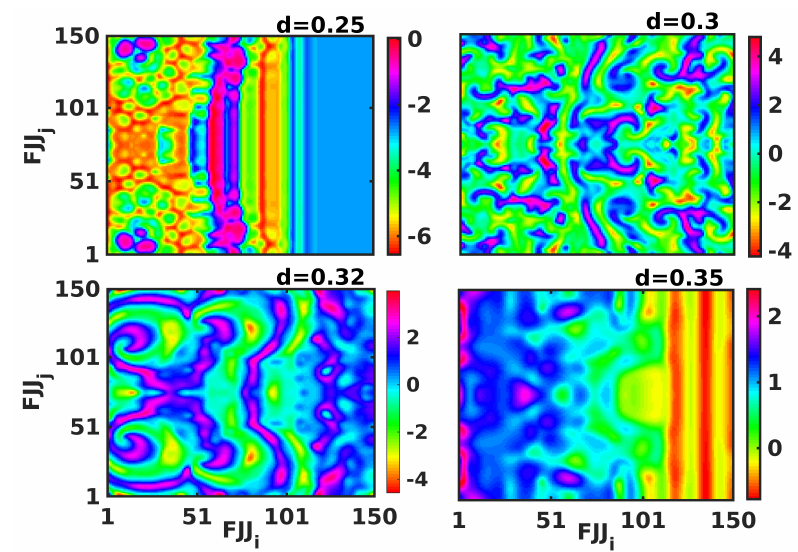
Figure 8. The energy of a network of FJJ by fixing d = 0.25, d = 0.3, d = 0.32, and d = 0.35. Other parameter values are defined as D = 1.0, A = 5.0, q = 0.98, and δ = 0.0.